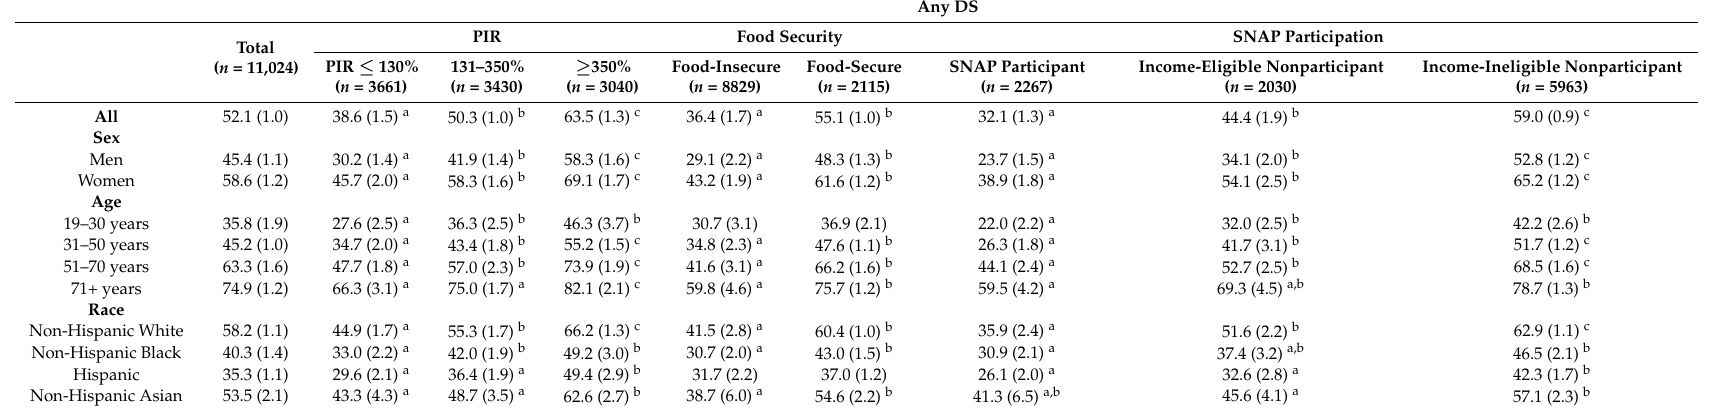
Table 2. Estimated prevalence (%) of dietary supplement (DS) use by selected poverty and demographic indicators, among U.S. adults, 2011–2014 1,2